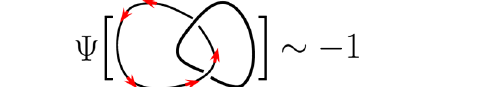
FIG. 8. Loop wave functions of the E phases: The amplitude changes sign whenever a directed loop links with an undirected